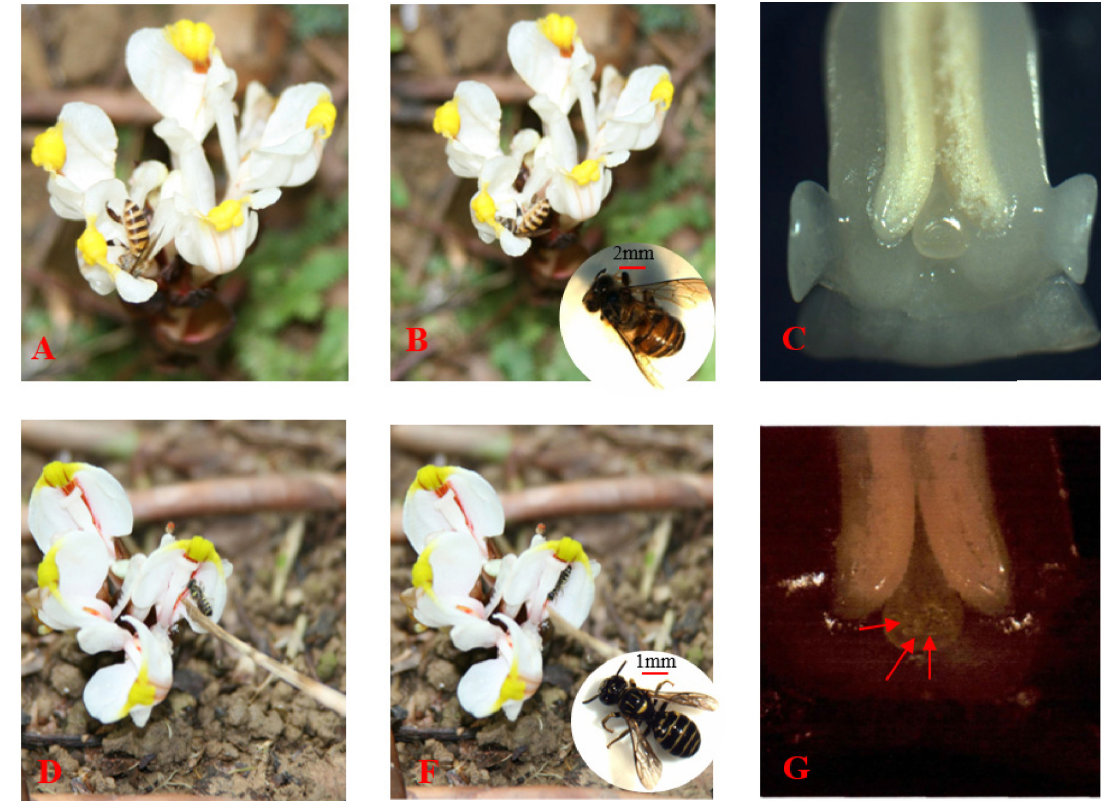
Fig 6. Foraging dynamics of honey bees (A, B) and Nomia strigata Smith (D, F), pollination effectiveness of honey bees (C) and Nomia strigata Smith (G) were observed using a